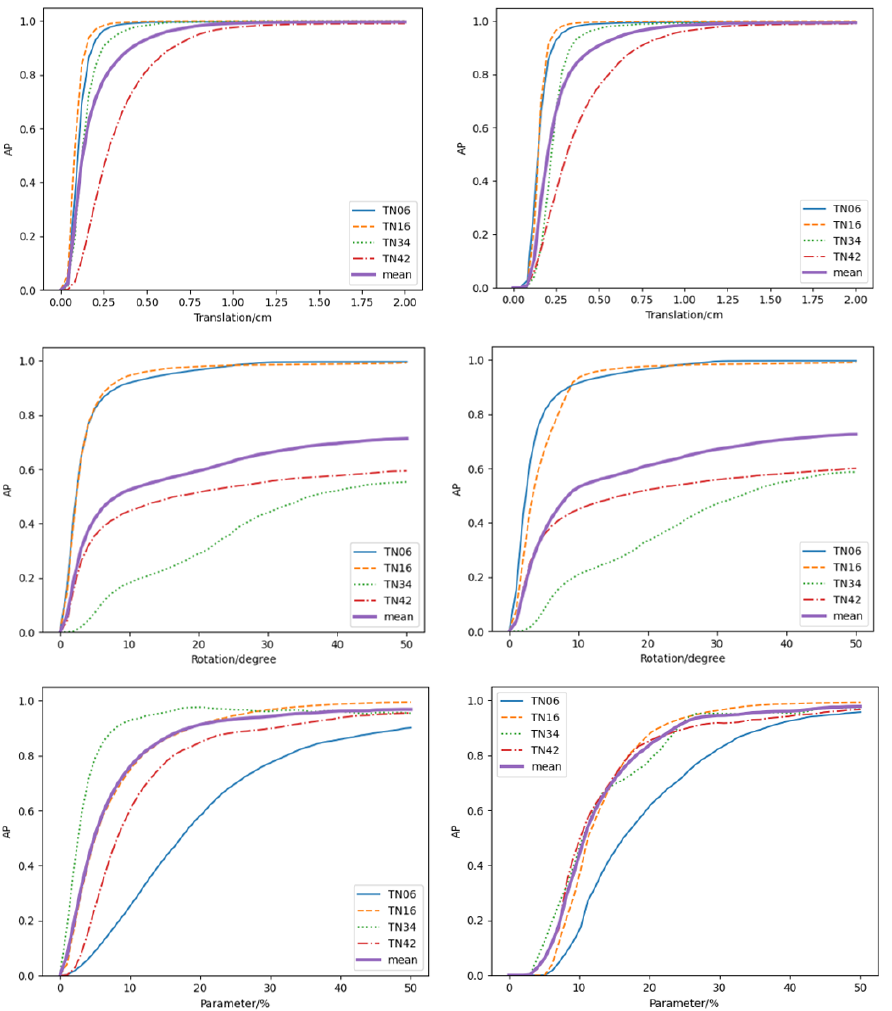
Figure 8. Further experiment results on the evaluation of translation, rotation, and parameter val- ues prediction. The images in the left column are the results evaluated on TEST-L for learning performance, and the images in the right column are the results evaluated on TEST-G for generaliza- tion